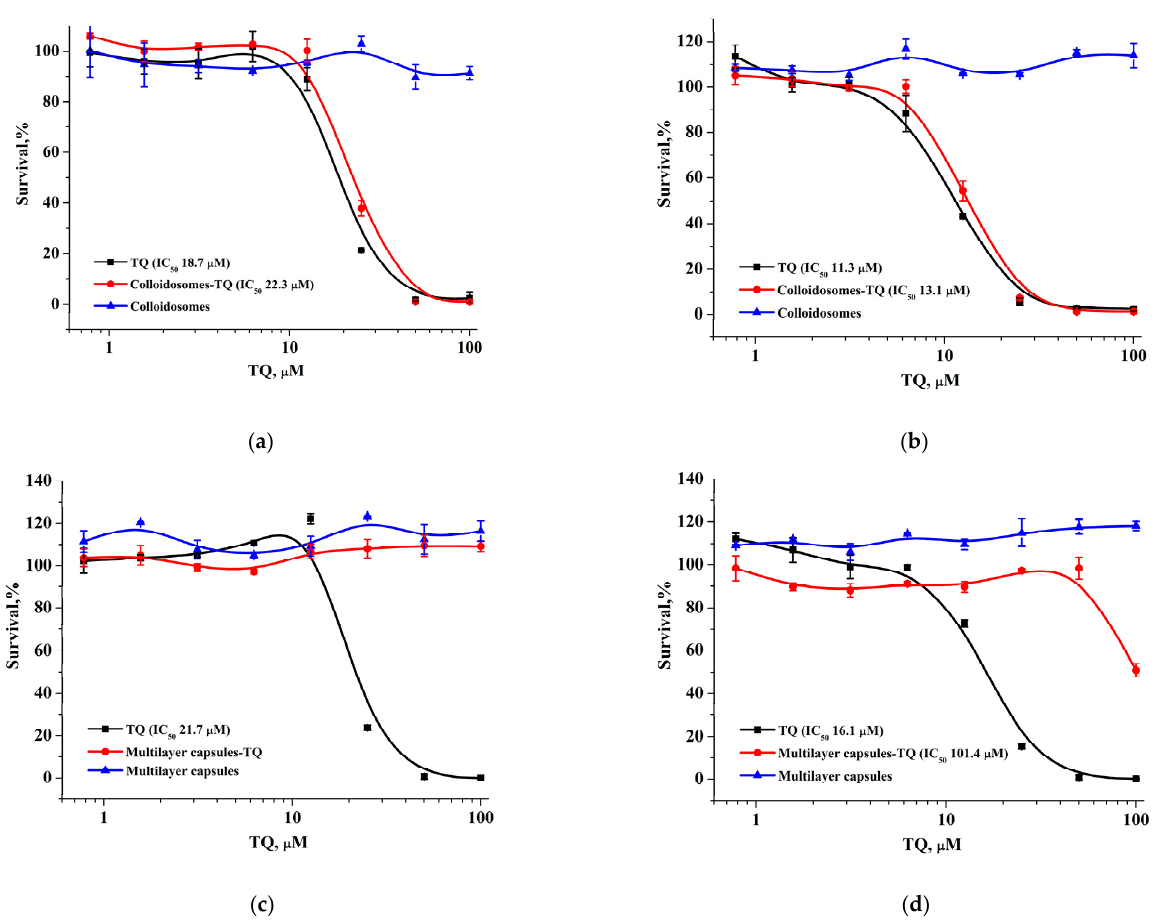
Figure 11. MCF-7 ( a , c ) and BJ-5ta ( b , d ) cell survival after 72 h incubation with the TQ colloidosomes, TQ-loaded capsules, and blank capsules.